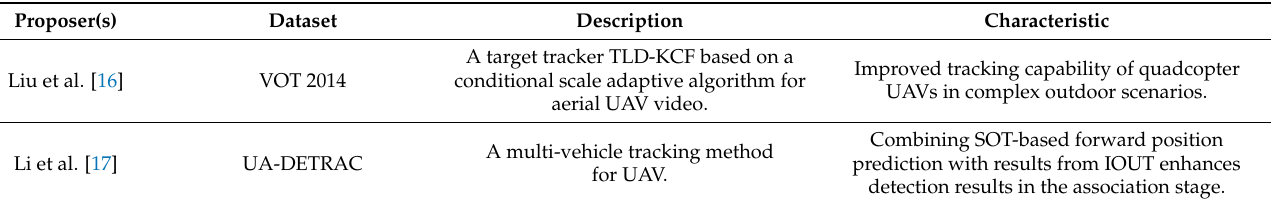
Table 1. Details of some UAV target tracking